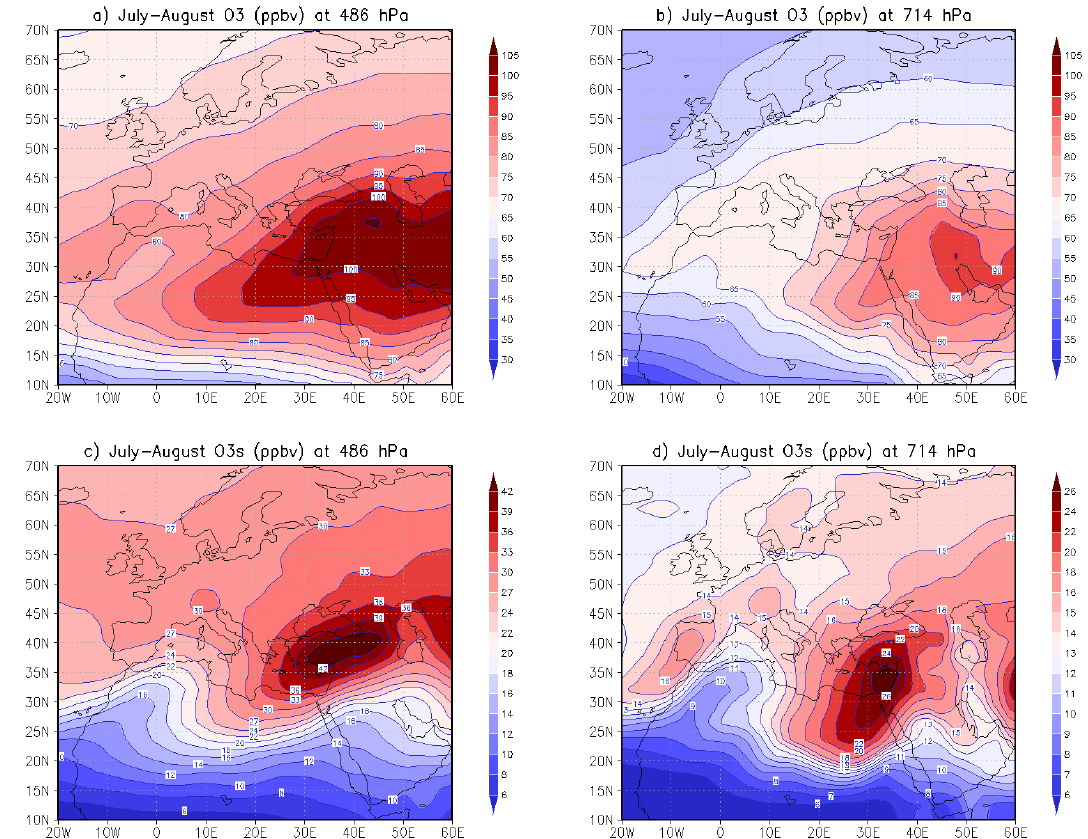
Fig. 6. EMAC July–August average fields of simulated ozone (ppbv) and the stratospheric ozone tracer O3s (ppbv) over the period 1998–2009 Figure 6. EMAC July-August average fields of simulated ozone (ppbv) and the 913 at 486hPa (a, c) and at 714hPa (b, d) , stratospheric ozone tracer O3s (ppbv) over the period 1998-2009 at 486 hPa (a, c) and 914 at 714 hPa (b, d), respectively. 915